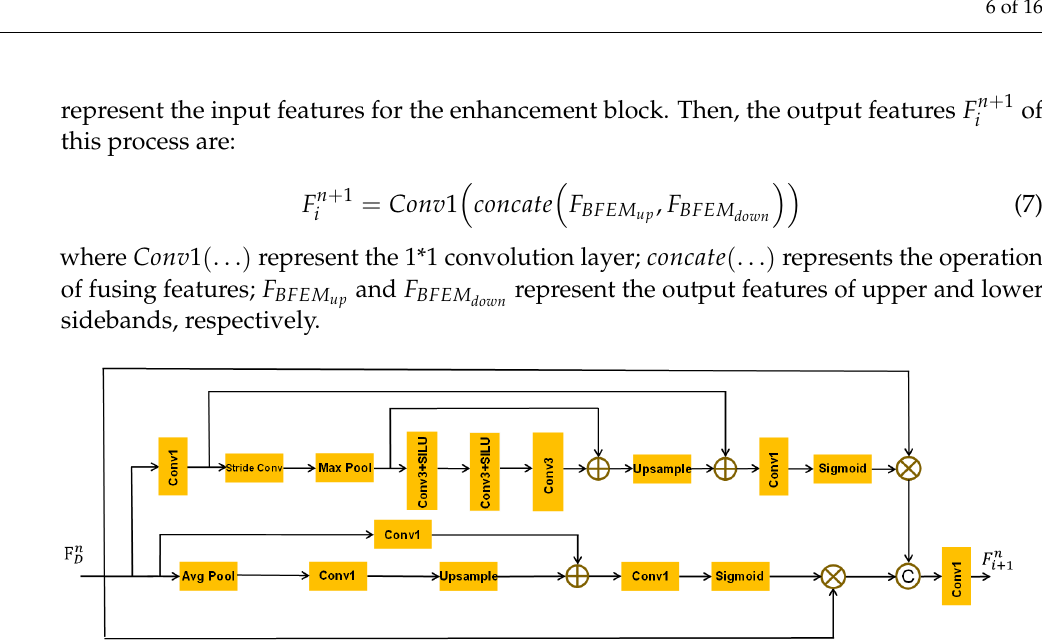
Figure 4. The structure of our well-designed bilateral bands. The upper sideband is used to enhance the features, and the lower sideband is used to extract the complex background information. © rep- resents the feature fusion; and represent the element-wise summation and the element-wise ⊕ ⊗ summation multiplication,